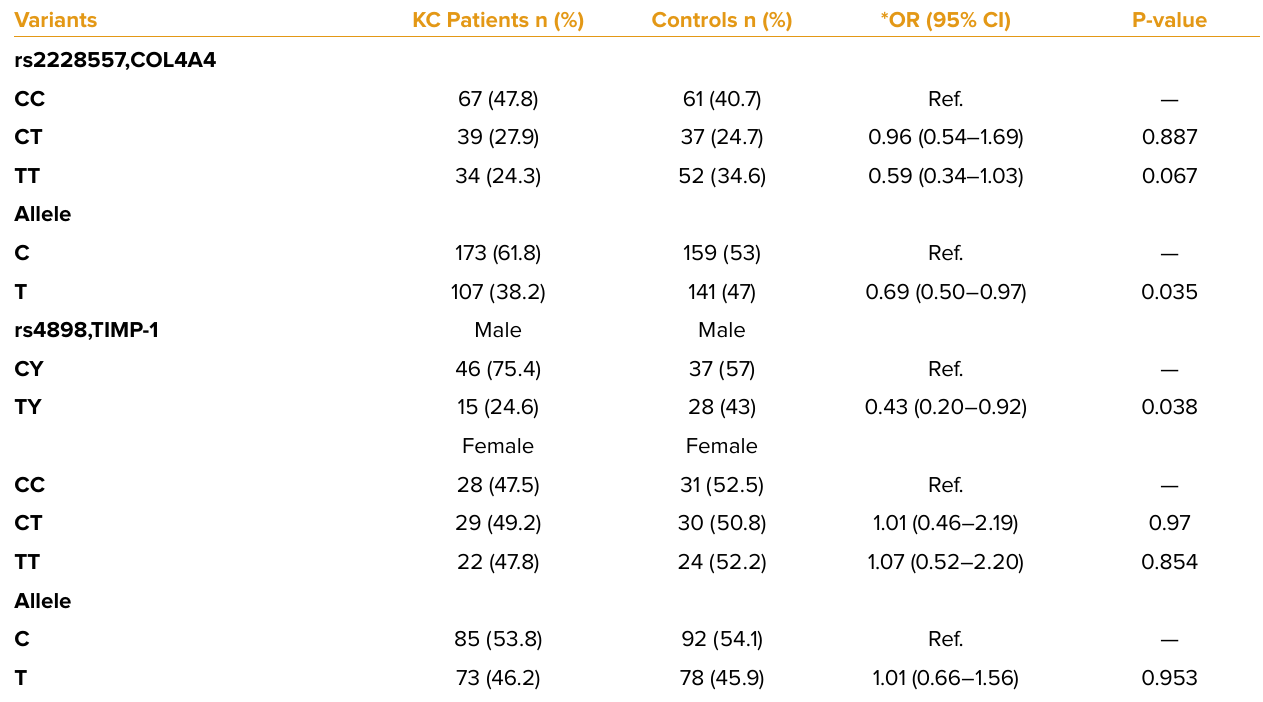
Table 2. Genotype and allelic frequencies of COL4A4 rs2228557 and TIMP-1 rs4898 polymorphisms between keratoconus (KC) patients and healthy controls.